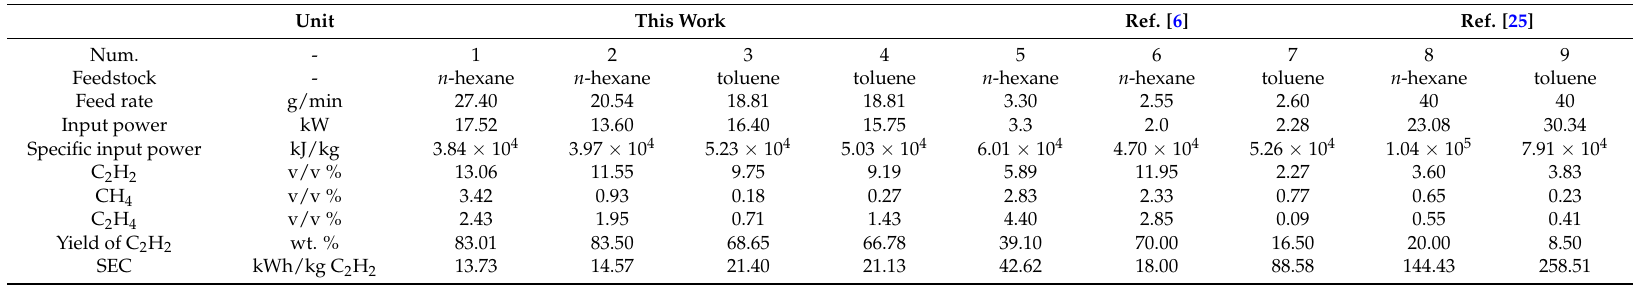
Table 1. Typical operating conditions and performance of liquid hydrocarbons pyrolysis process. Unit This Work Ref. [6] Ref. [25]